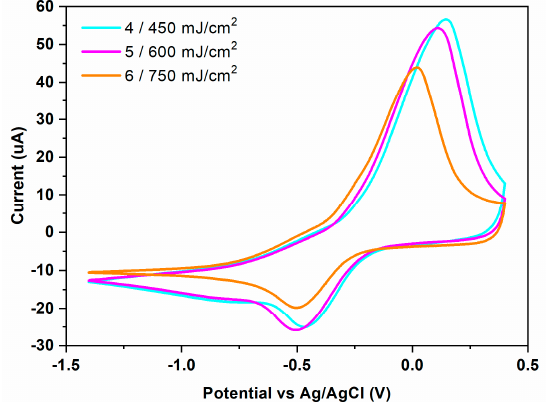
Figure 9. Cyclic voltammogram of Cu 2+ (100 ppm) in 0.1 M acetate buffer solution (pH = 5.0 upH) recorded on PEDOT:PSS: GO modified SPE electrodes fabricated at different laser fluences via LIFT from a donor film with an intermediate triazene polymer layer.